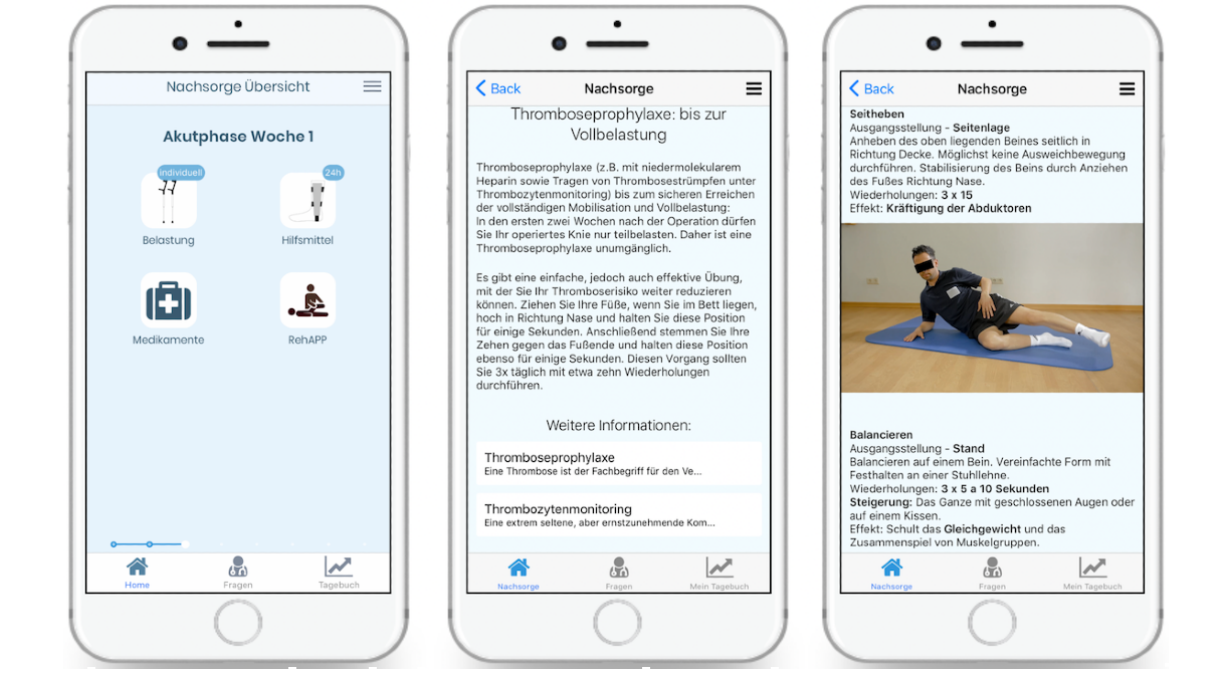
Figure 1. App screen view: (a) timeline-based aftercare plan, (b) information, and (c) training